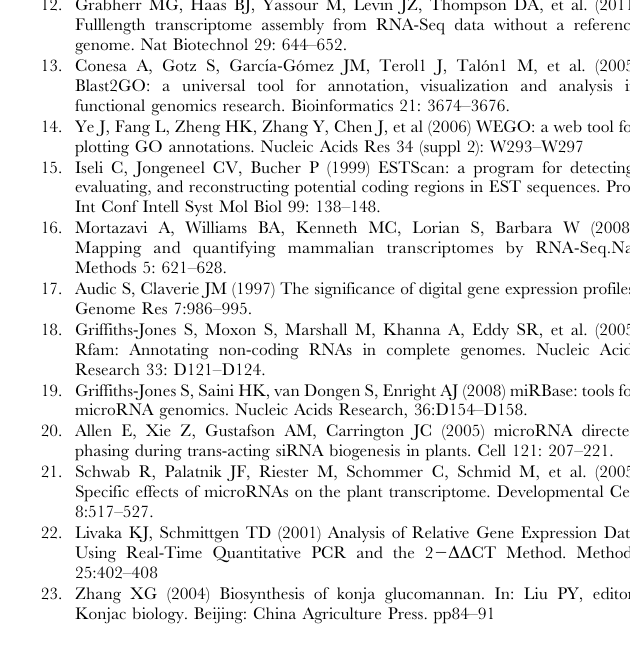
Table S1 List of primers used for RT-PCR. Table S2 Summary of unigene annotation. Table S3 Differentially expressed unigenes. Table S4 Statistic of conserved miRNAs. Table S5 Annotation of the potential target